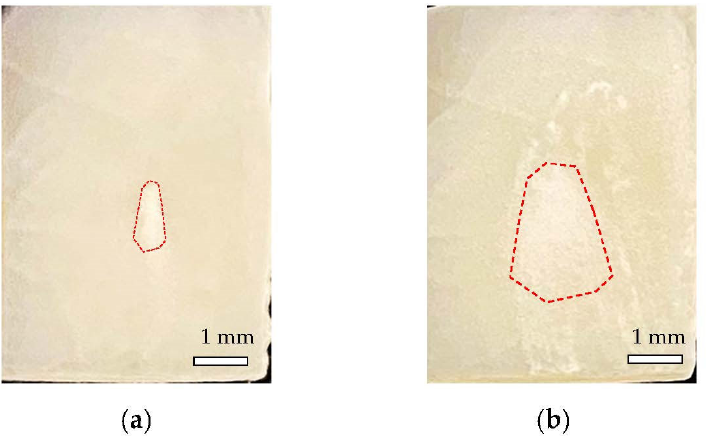
Figure 3. Gross appearances of specimens and the deposited α‐ TCP layer immediately after the Er:YAG ‐ PLD for ( a ) 1 pulse and ( b ) 25 pulses. Er:YAG-PLD for ( a ) 1 pulse and ( b ) 25